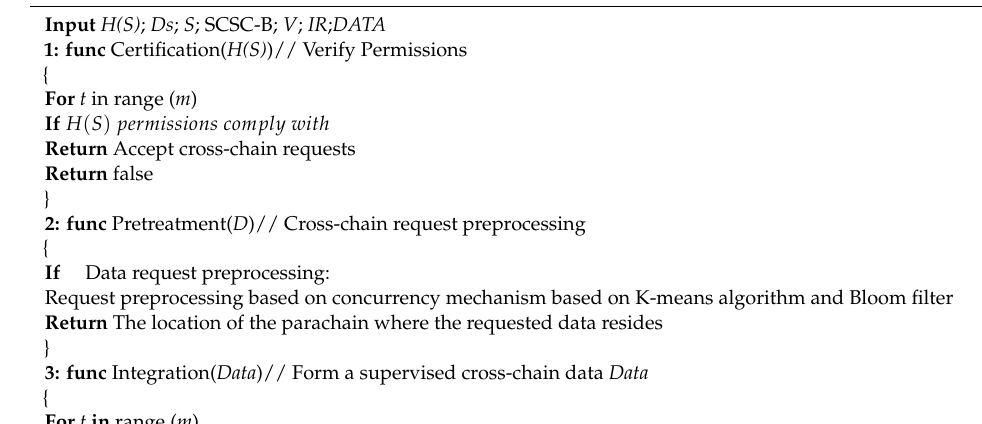
Algorithm A3: Supervise cross-chain smart contract